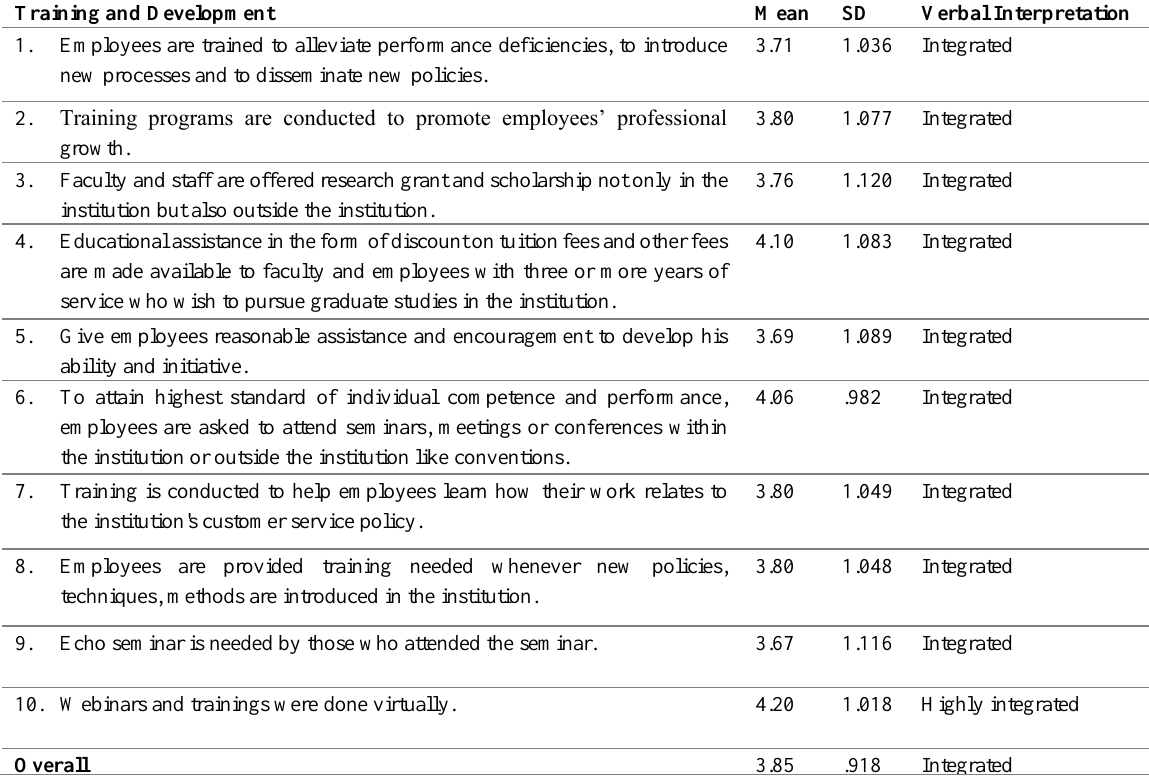
Table 8: Extent of Integration of Social Responsibility to Training and Development as Perceived by Respondents Training and Development Mean SD Verbal